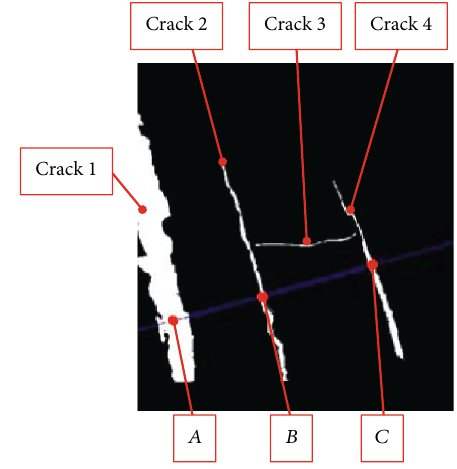
Figure 5: Measurement of the multicrack